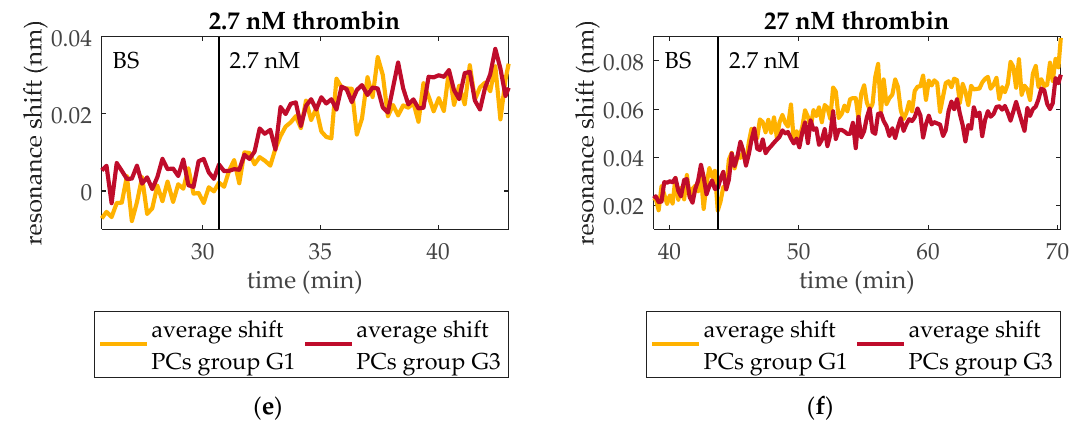
Figure 7. Resonance shift experienced by PCs groups G1 and G3 when increasing concentrations of thrombin are consecutively flowed over time. ( a ) Shift experienced by PCs group G1 and their average shift. ( b ) Shift experienced by PCs group G3 and their average shift. ( c ) Thrombin (27 pM) solution is not detected neither by PCs group G1 nor by group G3. ( d ) Thrombin (270 pM) solution provokes an average PBG shift of 12 pm for both PCs groups. ( e ) Thrombin (2.7 nM) solution provokes an average PBG shift of 24 pm and 22 pm for PCs groups G1 and G3, respectively. ( f ) Thrombin (27 nM) solution provokes an average PBG shift of 52 pm and 44 pm for PCs groups G1 and G3, respectively.